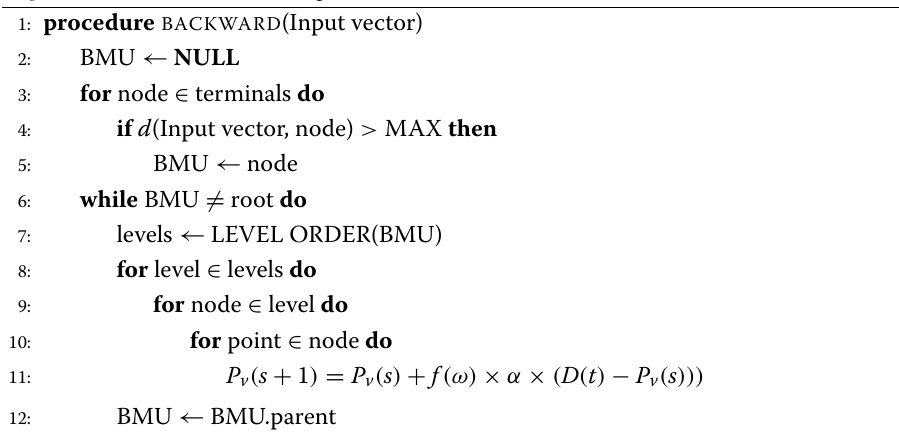
Algorithm 3 Backward training of Neural